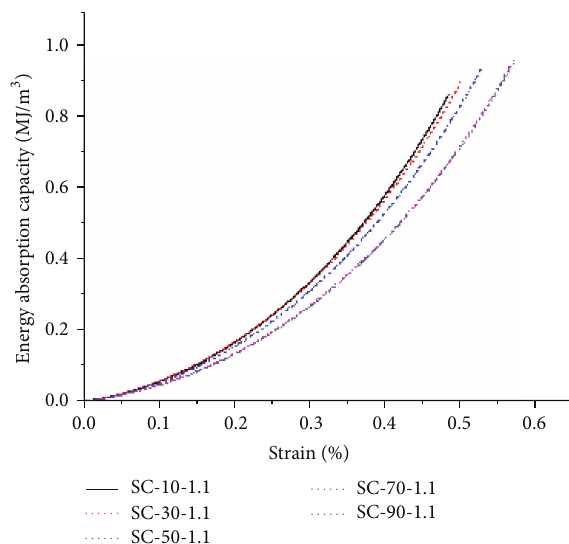
Figure 6: Energy absorption capacity of the WTDCEs.